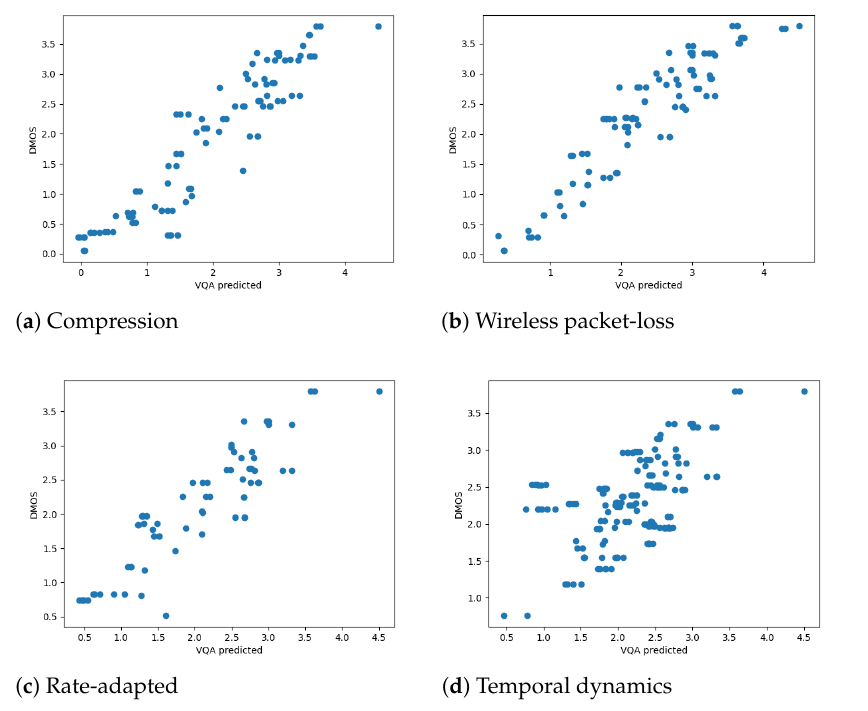
Figure 9. RAVA SSIM vs. DMOS for different distortion types (mobile).